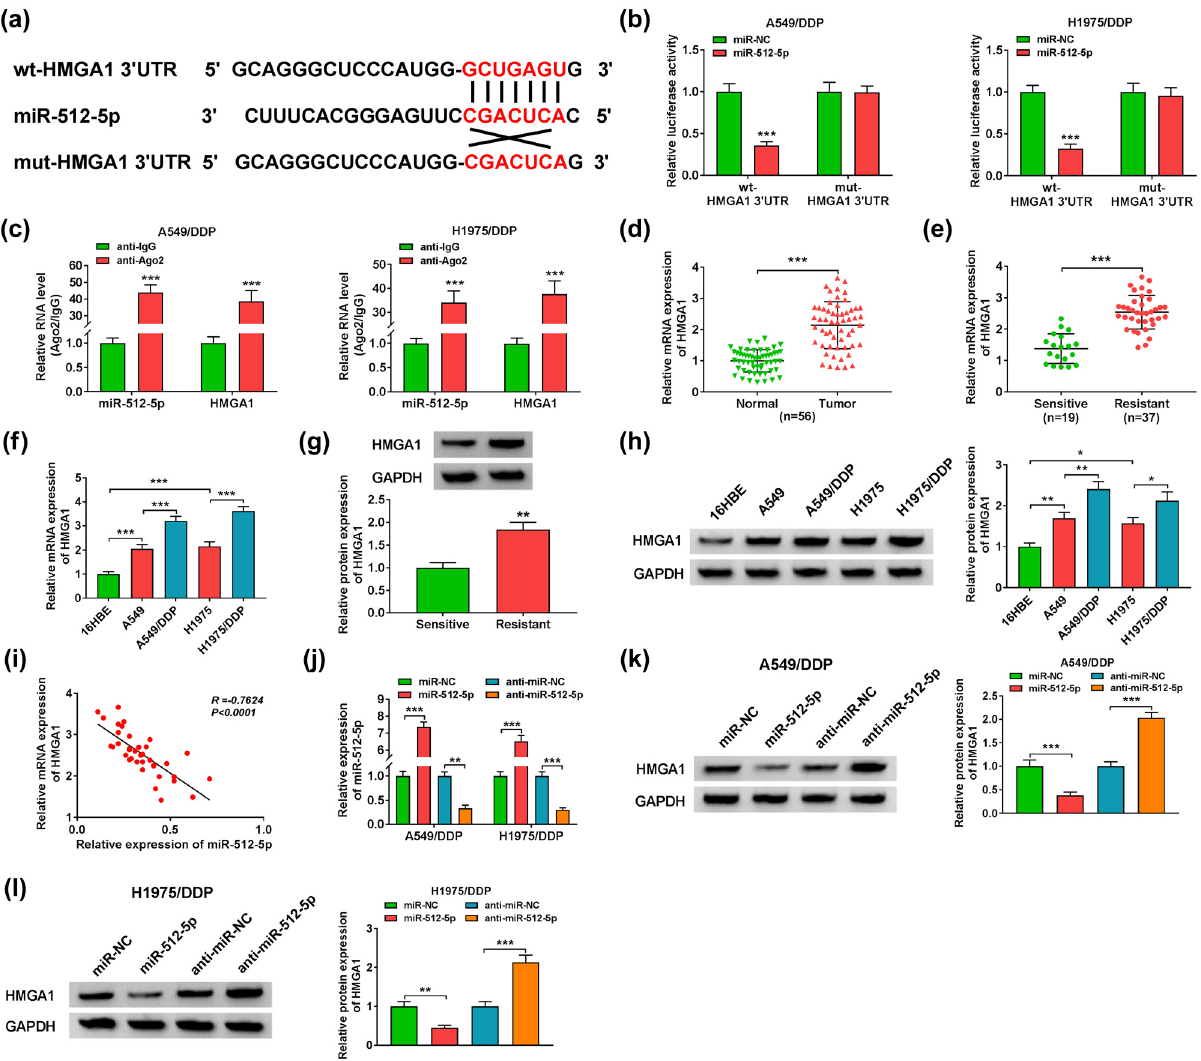
Figure 5: The target relationship between miR - 512 - 5p and HMGA1 in lung adenocarcinoma DDP - resistant cells. ( a ) Target Scan Human7.2 predicted the targeted binding sites of miR - 512 - 5p to HMGA1. ( b ) The luciferase activities of wt - HMGA1 3 ′ UTR and mut - HMGA1 3 ′ UTR were detected by using dual - luciferase reporter assay after transfected with miR - NC or miR - 512 - 5p. ( c ) The interaction between miR - 512 - 5p and HMGA1 was analyzed by using RIP assay after transfected with miR - NC or miR - 512 - 5p. ( d ) RT - qPCR was applied to measure the expression of HMGA1 in normal tissues and tumor tissues. ( e ) RT - qPCR was performed to analyze the expression of HMGA1 in sensitive tumor tissues and resistant tumor tissues. ( f ) The expression of HMGA1 in 16HBE, A549, A549/DDP, H1975, and H1975/DDP cells was tested by RT - qPCR. ( g ) The protein of HMGA1 in sensitive tumor tissues and resistant tumor tissues was measured by western blot. ( h ) The protein level of HMGA1 in 16HBE, A549, A549/DDP, H1975, and H1975/DDP cells was examined by western blot. ( i ) Pearson correlation analysis was used to analyze the correlation between miR - 512 - 5p and HMGA1. ( j ) RT - qPCR was applied to measure the expression of miR - 512 - 5p in A549/DDP and H1975/ DDP cells after transfected with miR - NC, miR - 512 - 5p, anti - miR - NC, or anti - miR - 512 - 5p. ( k and l ) Western blot was performed to test the protein level of HMGA1 in A549/DDP and H1975/DDP cells after transfected with miR - NC, miR - 512 - 5p, anti - miR - NC, or anti - miR - 512 - 5p. * P < 0.05, ** P < 0.01, *** P <